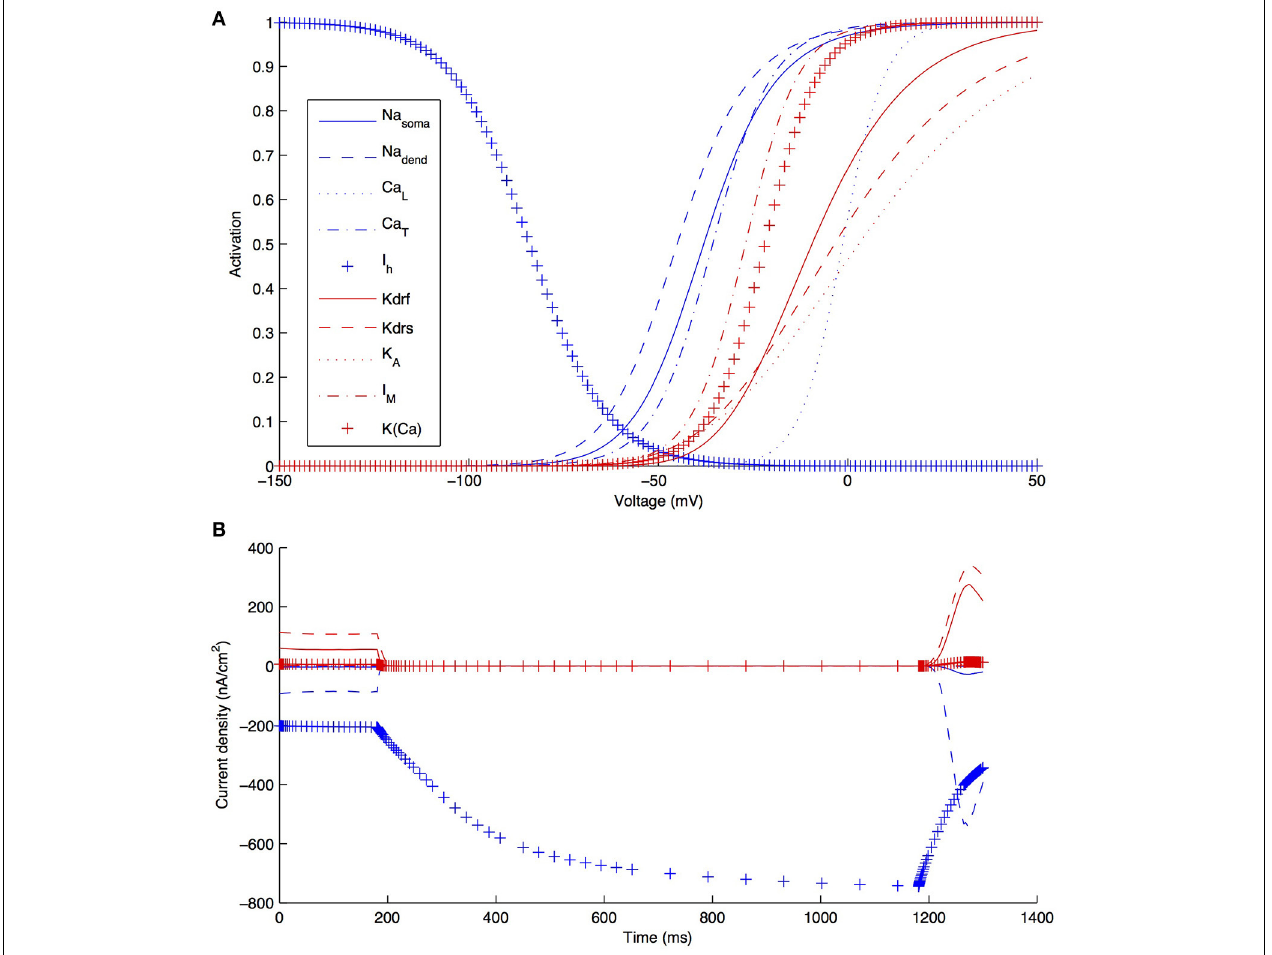
FIGURE 6 | Characteristics of all voltage-gated ion channels in the O-LM model. (A) The voltage-dependence of steady-state activation for all ionic currents in the models; (B) current flows through the